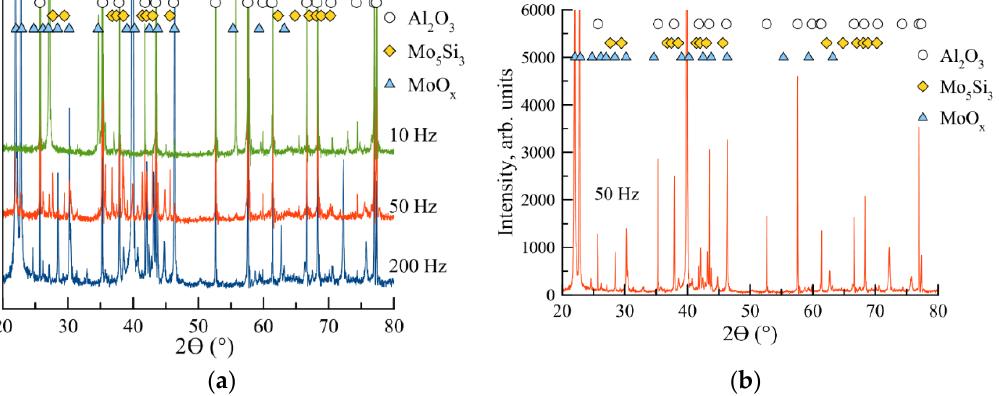
Figure 7. X ‐ ray diffraction patterns of the Mo ‐ Zr ‐ Si ‐ B coatings annealed in air at 1300 °C ( a ) and the Figure 7. X-ray diffraction patterns of the Mo-Zr-Si-B coatings annealed in air at 1300 ◦ C ( a ) and the coating deposited at 50 Hz and annealed at 1500 °C ( b ). coating deposited at 50 Hz and annealed at 1500 ◦ C ( b